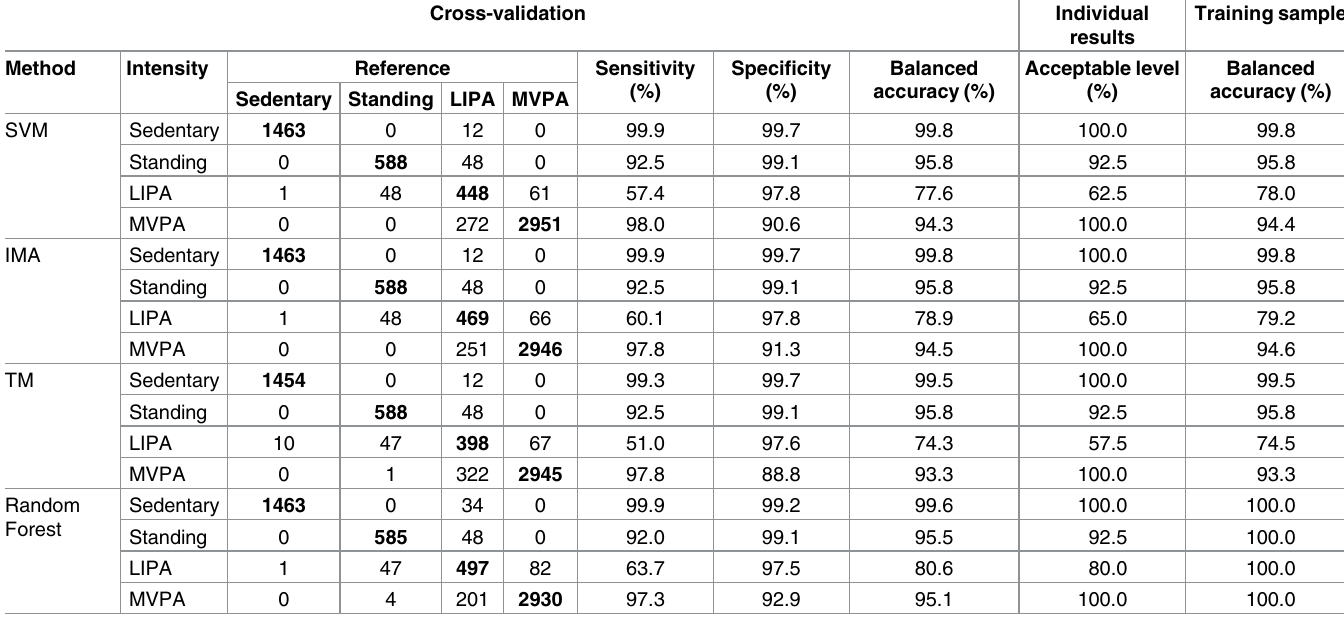
Table 3. Algorithm cross-validation confusion